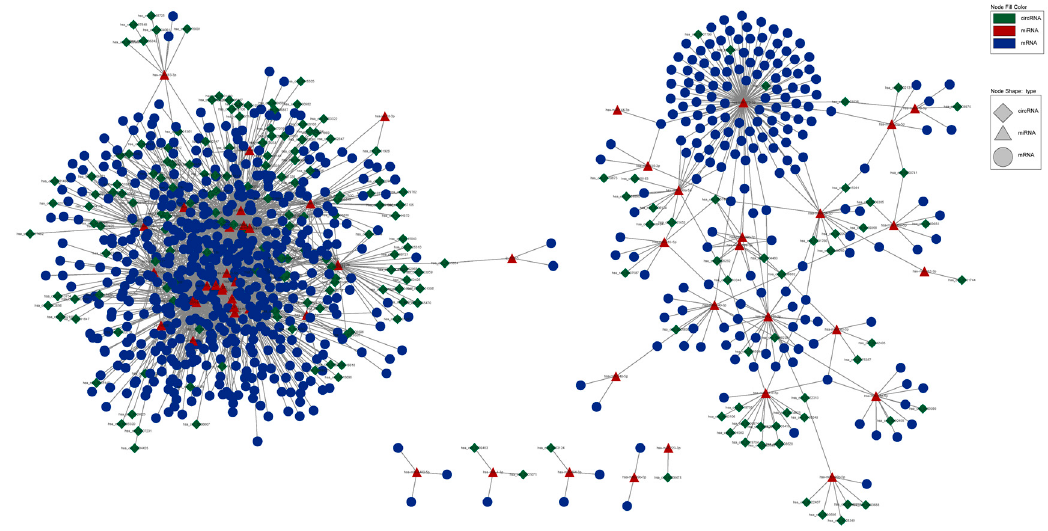
Figure 5. The circRNAs–miRNA–mRNA competing endogenous RNA network. Overall regulatory networks of circRNAs, miRNAs and mRNAs containing high-score interactions. Red triangles indicate up-regulated circRNAs, pink triangles indicate the down-regulated circRNAs, green circles represent miRNAs, blue rectangles indicate the mRNAs and a link between the nodes indicates the target